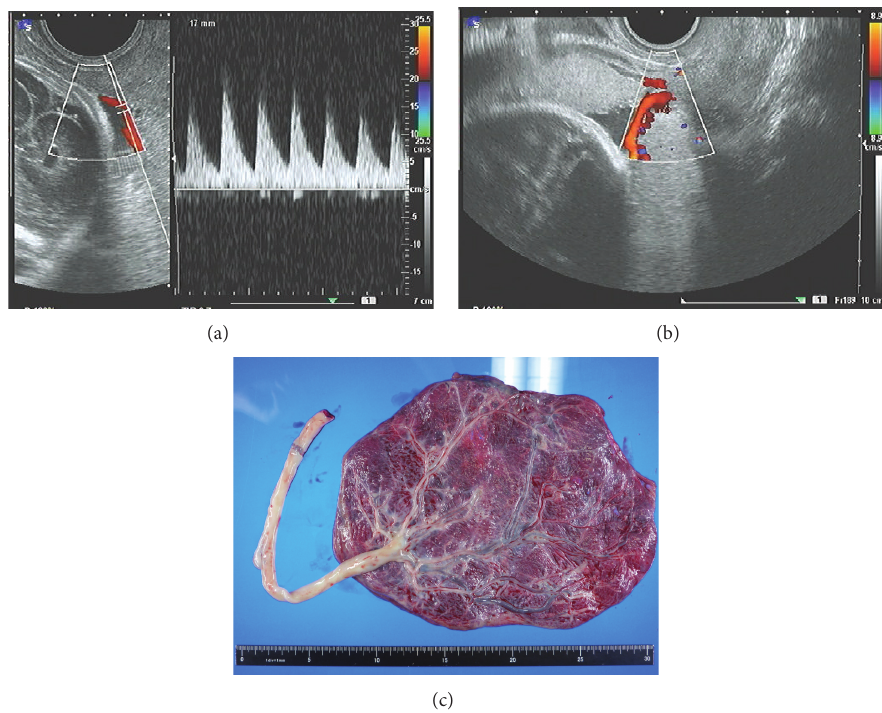
Figure 1: (a and b) First medical examination of the patient at our hospital. Transvaginal ultrasonography revealed membranous fetal vessels passing across the cervical internal os. The findings of color Doppler ultrasonography suggested that the vessels were the umbilical artery. (c) Images of the placenta. Observation during surgery refuted the previous diagnosis of vasa